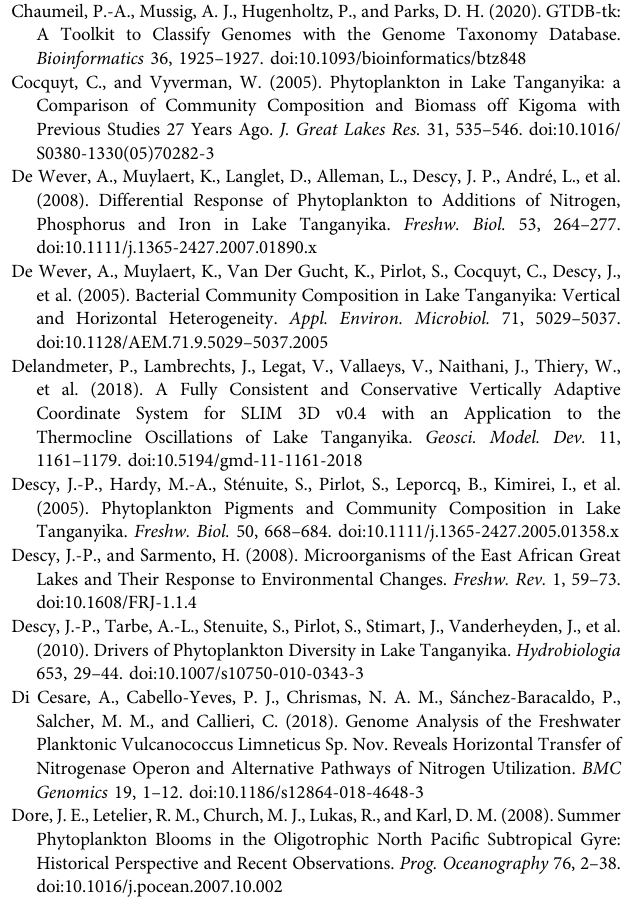
Supplementary Table 4 | Overview of the metagenome samples, including the sampling date and depth, as well as the number of raw and fi ltered sequences (after using prinseq), and the accession number in the NCBI